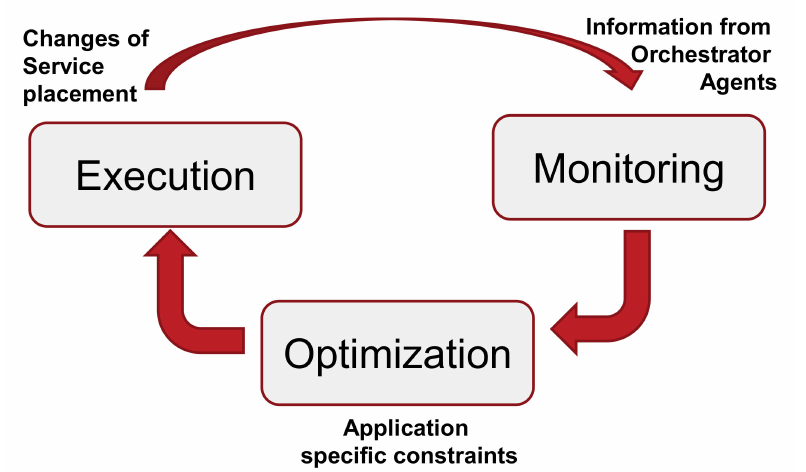
Figure 3. Control cycle inside the